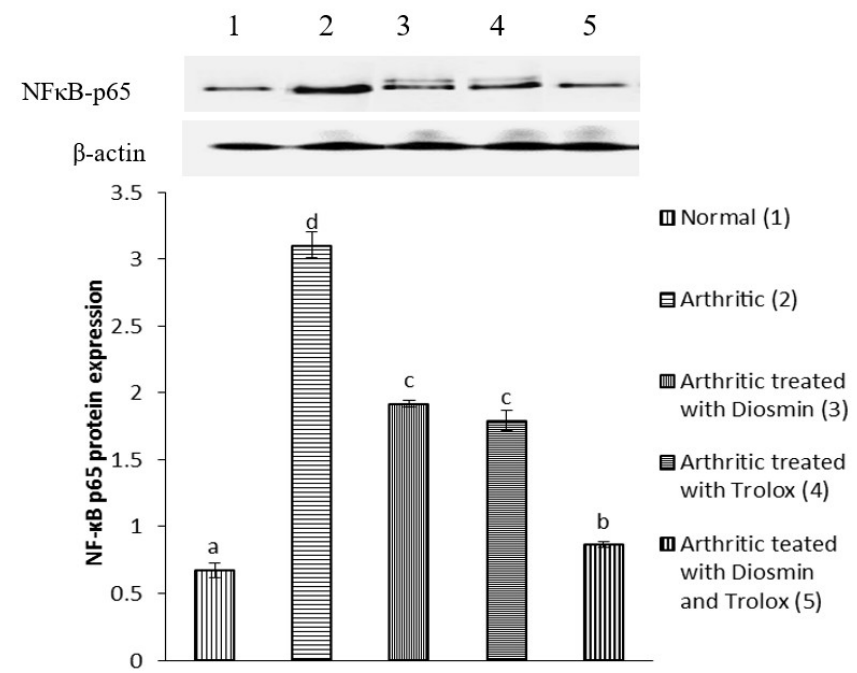
Figure 5. Effect of diosmin, trolox and their combination on NF- κ B p65 protein expression level in CFA-induced arthritic rats. Means that have the same symbol (s) are not significantly different ( n = 3).